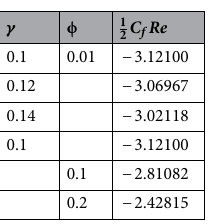
Table 4. Skin friction coefficient values with respect to γ and φ